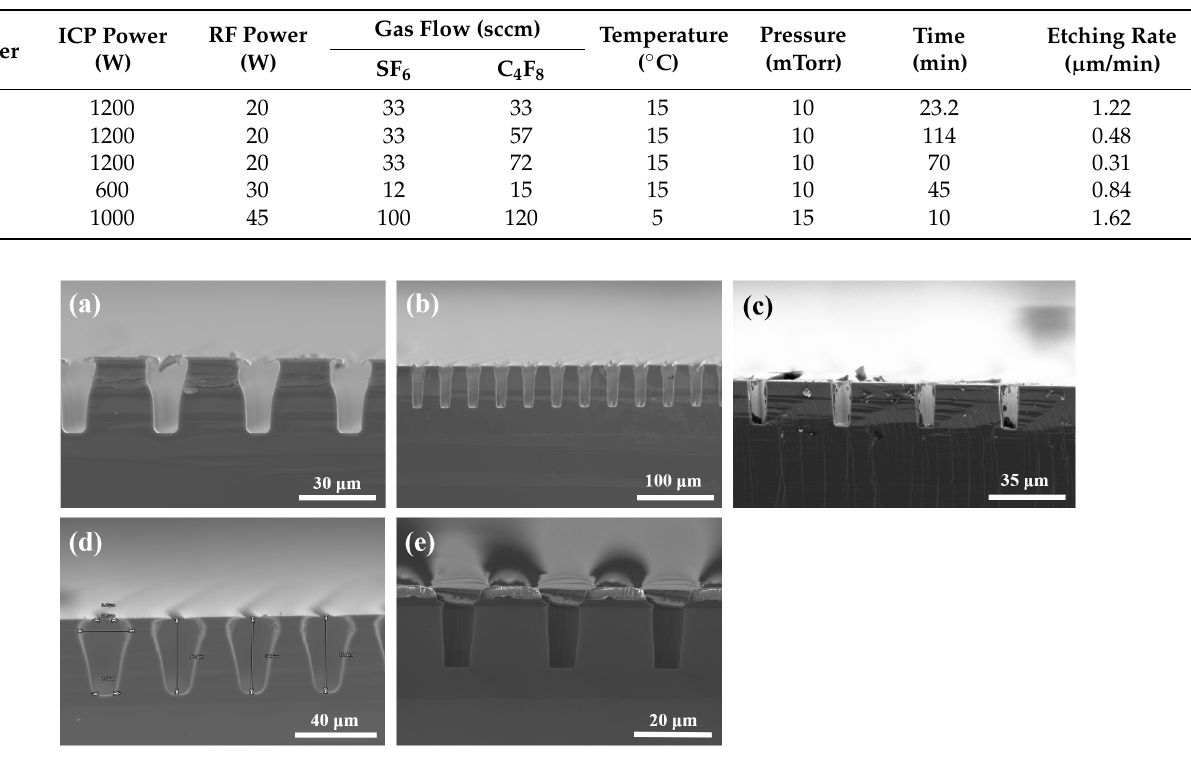
Figure 4. SEM images of ( a ) trenches and ( b ) sidewall of micro trenches by Bosch process.